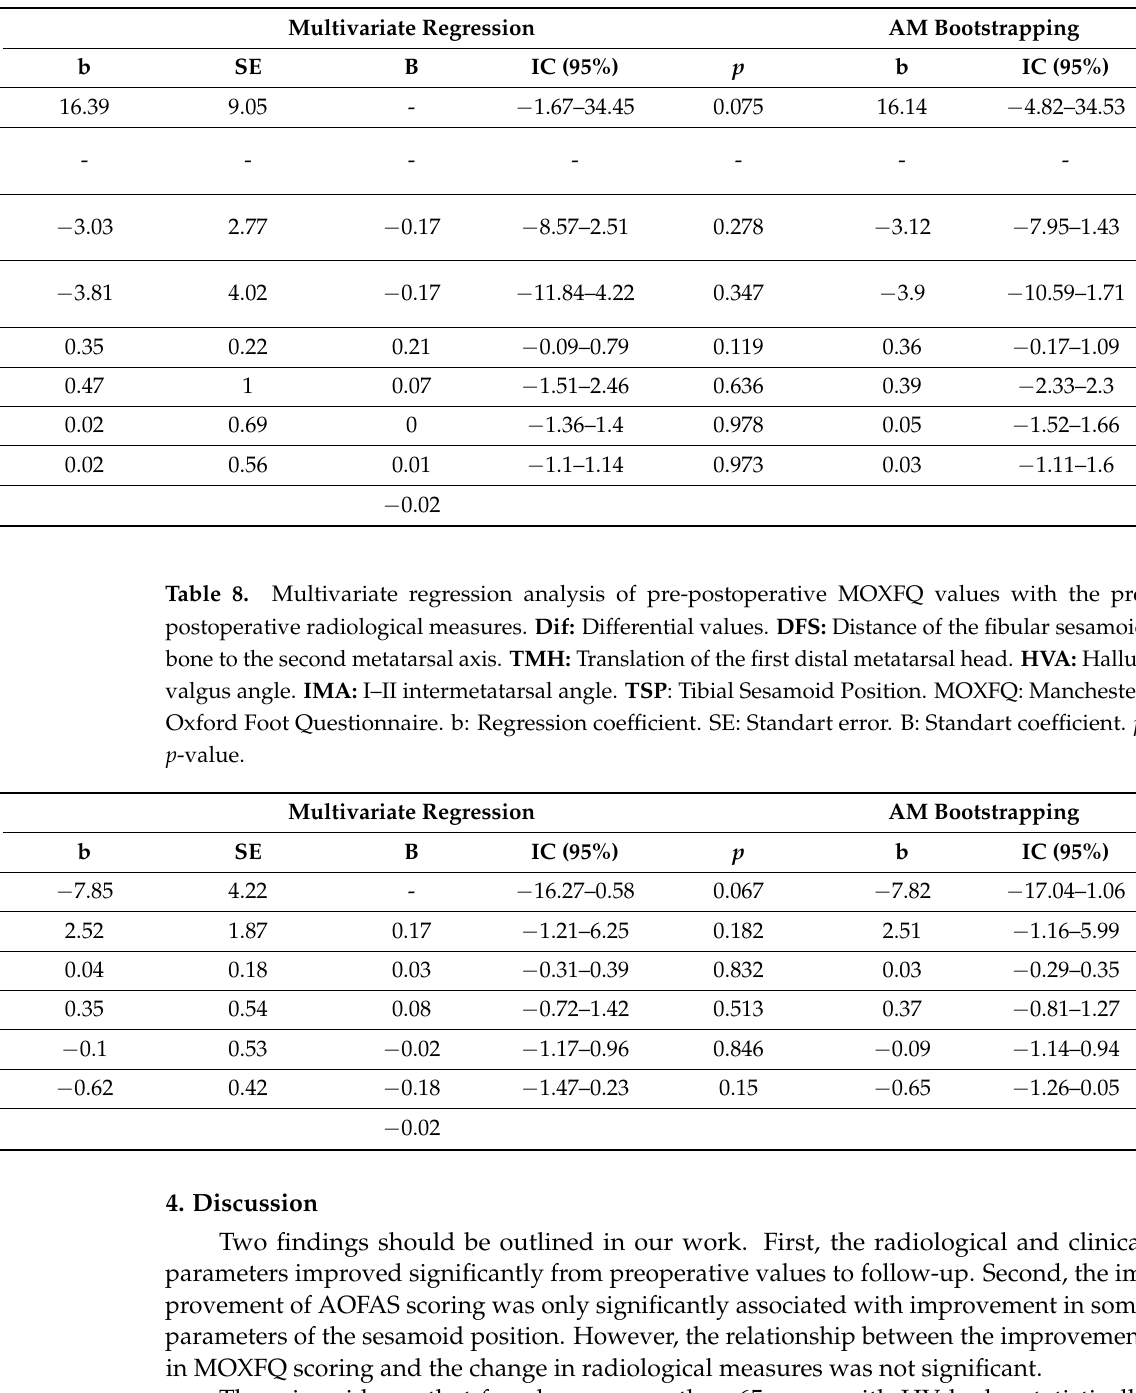
Table 7. Multivariate regression analysis of postoperative MOXFQ values with the postoperative radiological measures. Post: Postoperative values. DFS: Distance of the fibular sesamoid bone to the second metatarsal axis. TMH: Translation of the first distal metatarsal head. HVA: Hallux valgus angle. IMA: I–II intermetatarsal angle. TSP : Tibial Sesamoid Position. MOXFQ: Manchester-Oxford